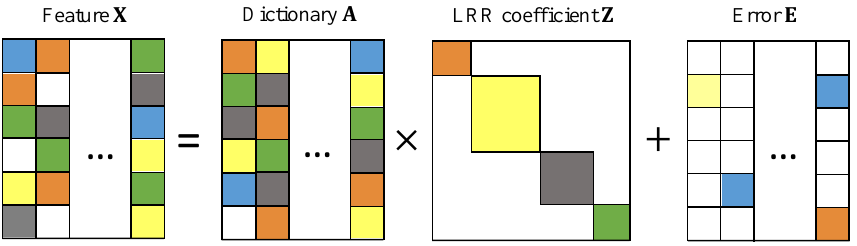
Figure 2. The representation with a diagonal-block